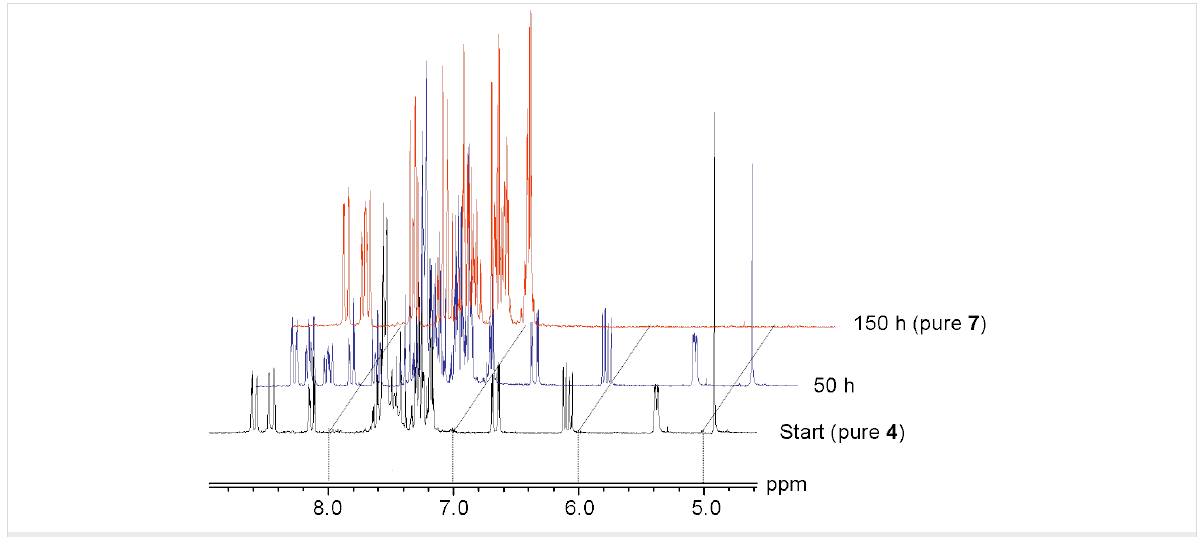
Figure 1: 1 H NMR spectra (200 MHz) of 4 in CDCl 3 solution and time dependence.